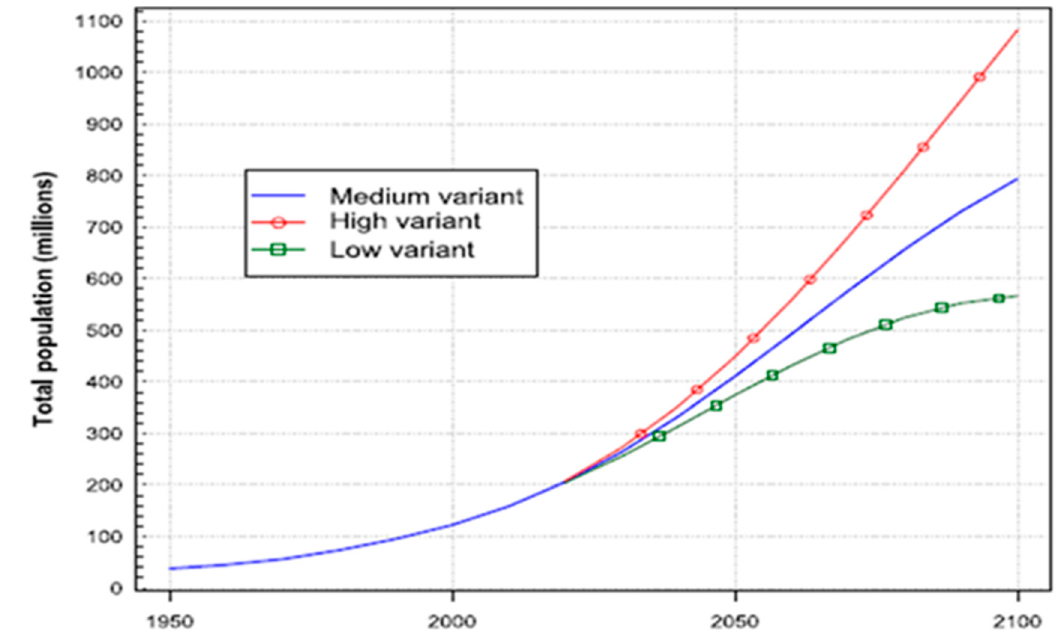
Figure 1. Total population of Nigeria by variant. Source: United Nations, Department of Economic and Social Affairs, Population Division [27].